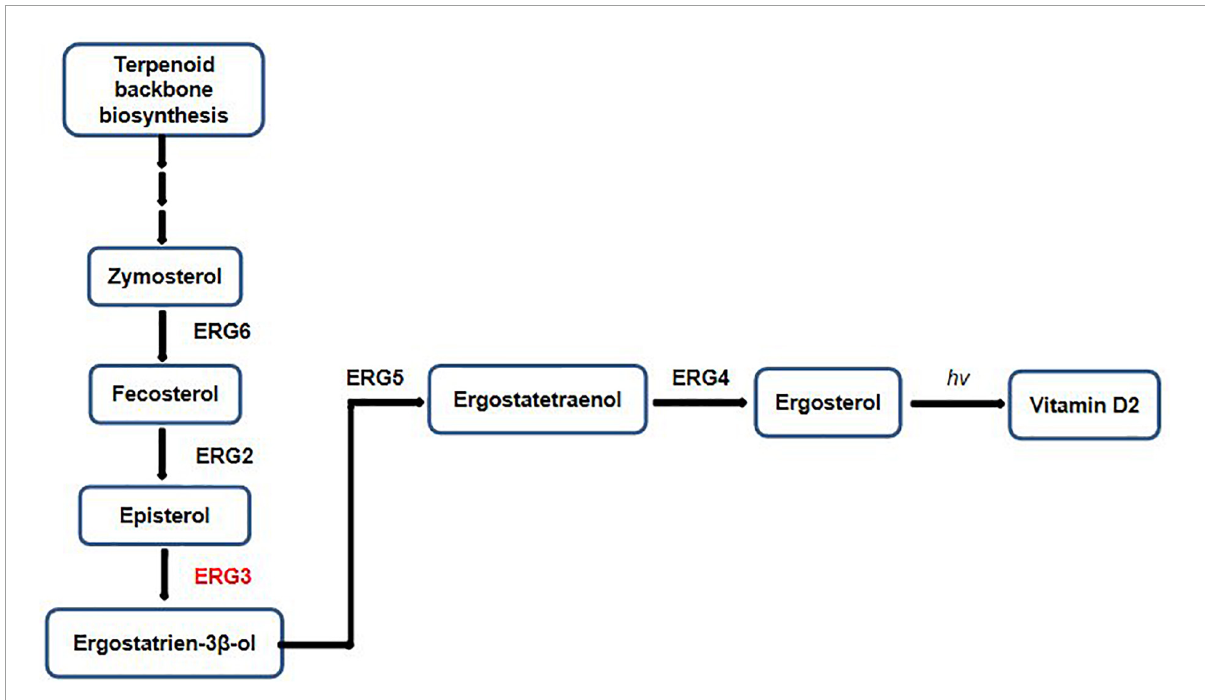
FIGURE6 Factors and intermediates of the fungal ergosterol biosynthetic pathway.